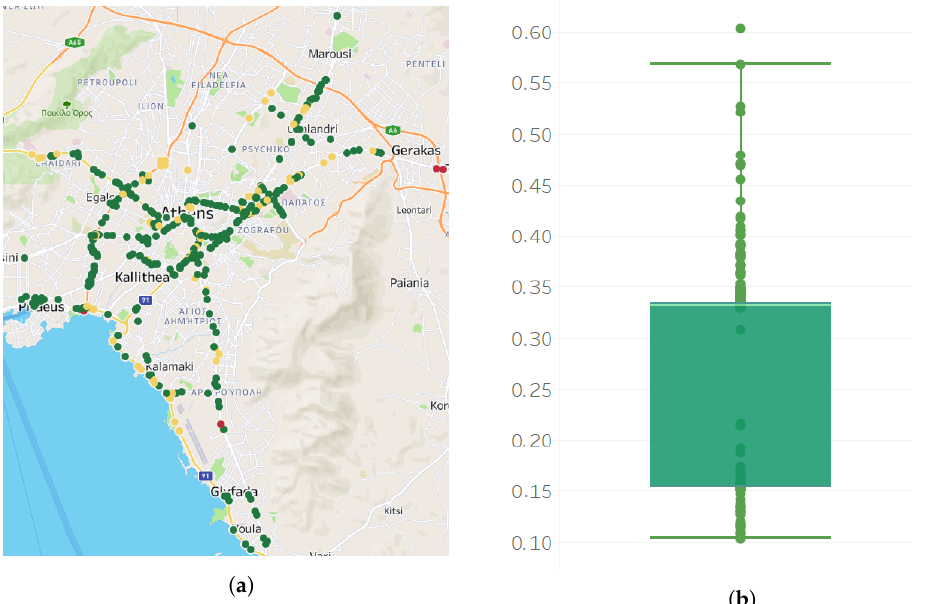
Figure 3. Map of sensors and boxplot for the missing values per sensor. ( a ) View of the 420 sensors on a map. Each point on the map represents a sensor. Red color marks represent sensors with higher percentages of missing values, green marks sensors with low percentages of missing values. ( b ) Percent of missing values per sensor in a boxplot showing the lower (Q1) and upper (Q3) quartile, the median and mean values. Data falling outside the lower (Q1)–upper (Q3) quartile range are plotted as outliers of the